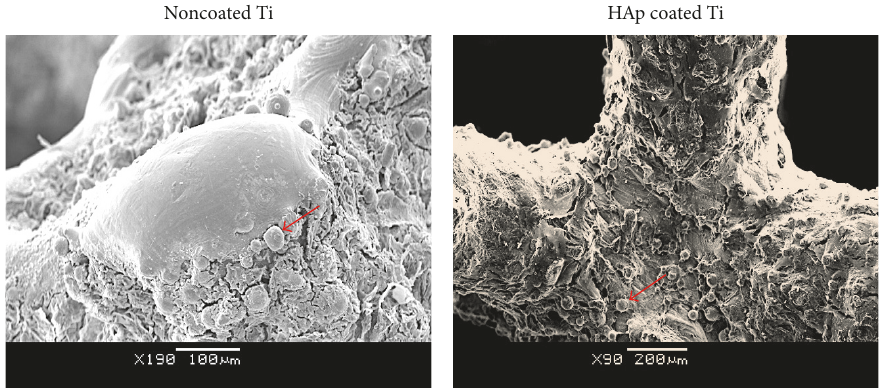
Figure 5: Cell morphology and osteogenesis on coated and noncoated Ti scaffolds; noncoated: flat cuboidal osteoblastic cells and mineral nodules (red arrow) on the scaffold peaks; coated: spindle-like cells and round mineral nodules (red arrow) attached to HAp coated scaffold